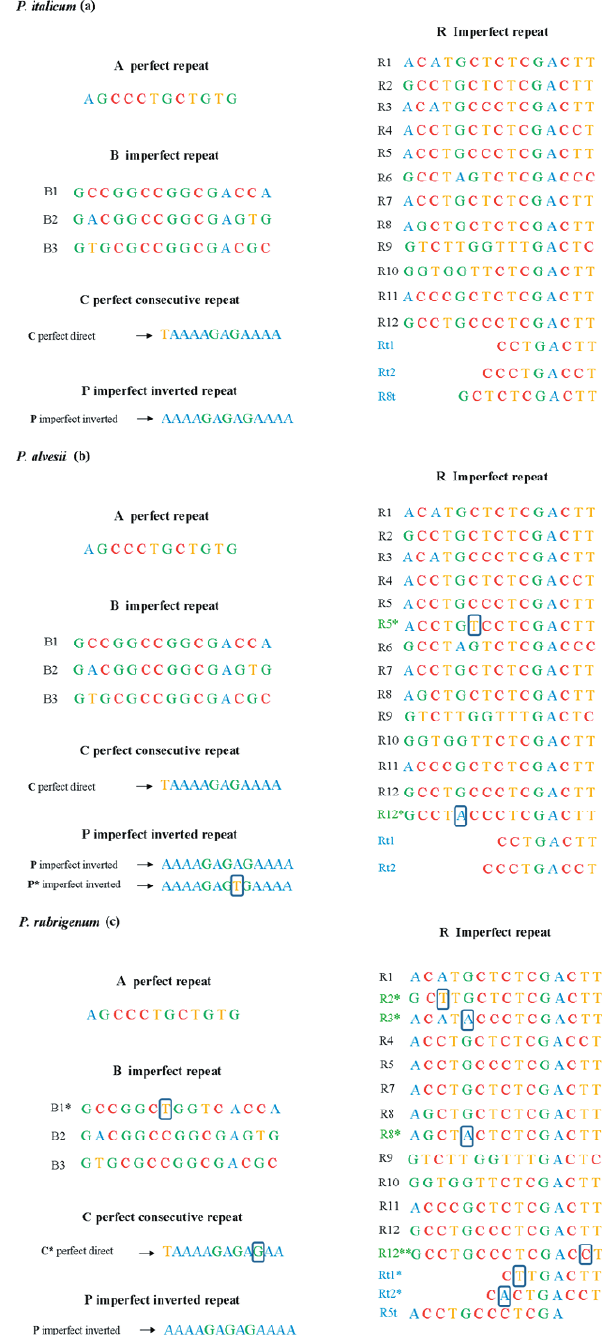
Figure 2. DNA short repeat elements A, B, C, P and R and their variants observed in the Phaeoacremonium italicum , P. alvesii and P. rubrigenum strains. Boxes indicate all polymorphic bases in ele- ments B and R modified